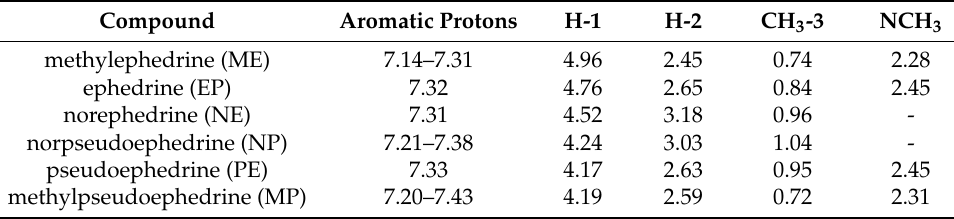
Table 1. 1 H-NMR signal assignments for the ephedrine alkaloid derivatives ( δ in ppm). Compound Aromatic Protons H-1